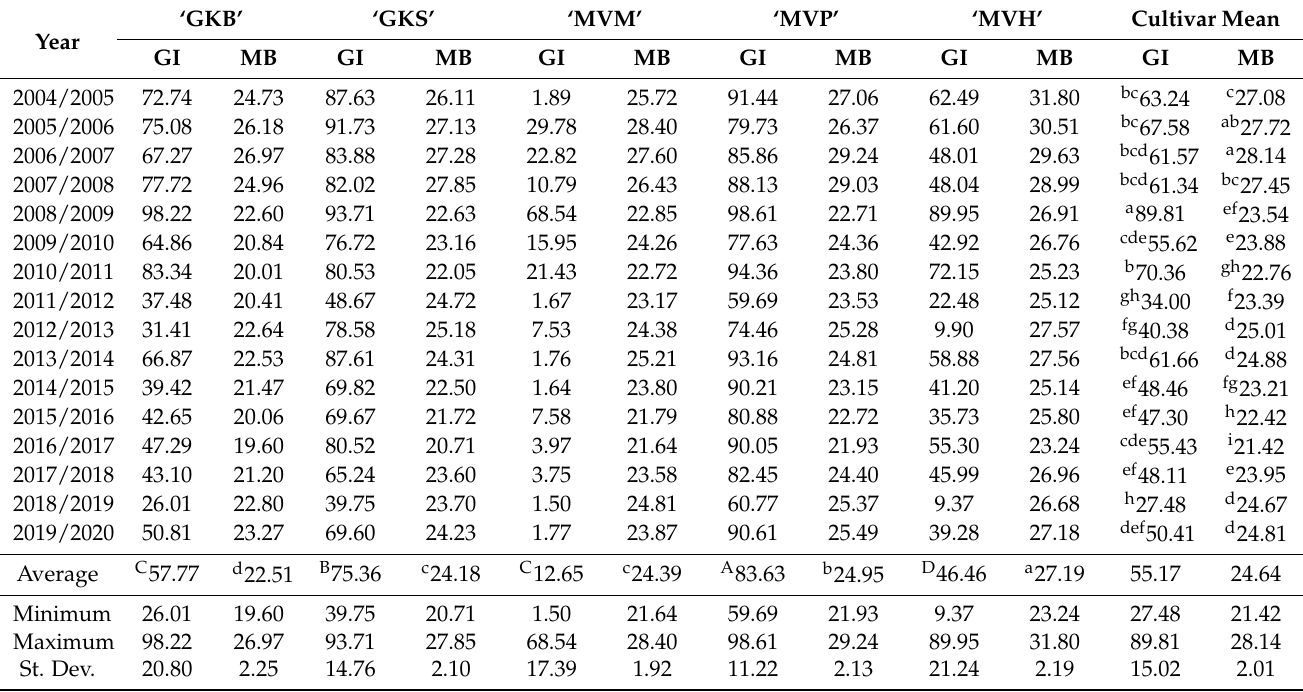
Table 2. Mean values of the gluten index and Minolta b* values of winter durum wheat cultivars (Martonv á s á r,